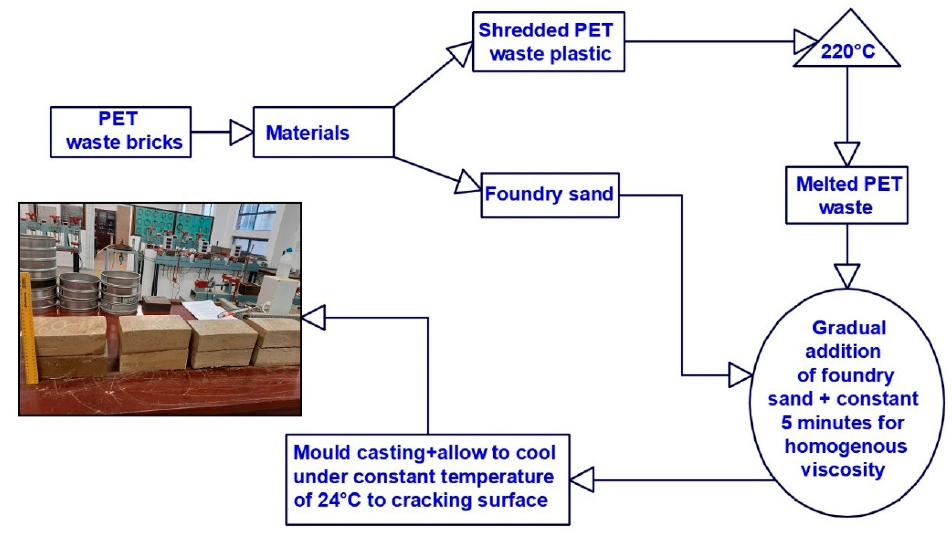
Figure 3. Process flow diagram of SPW bricks making.